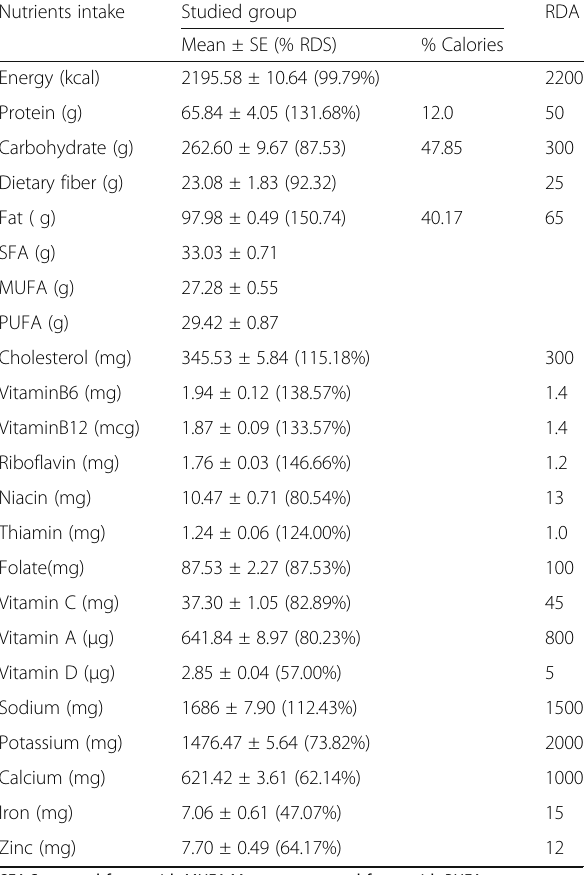
Table 3 Mean ± SE and the percentage of requirement of nutrients intake among the studied group